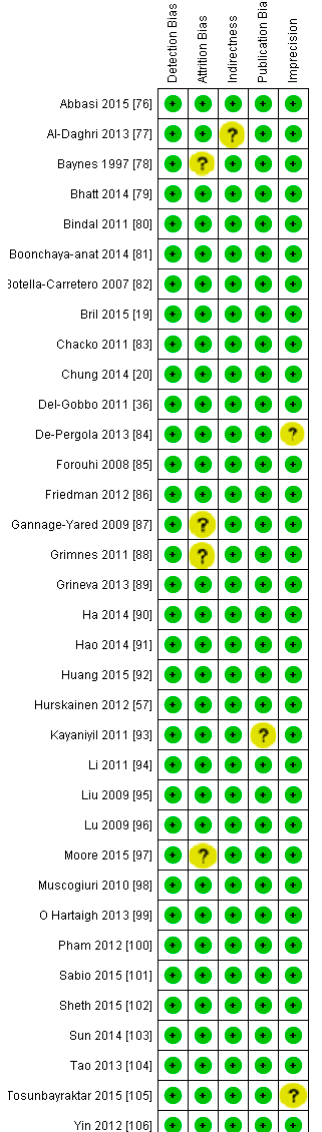
Figure 4. Meta-regression analysis for non-diabetic subject studies. Method of determination of vitamin D R 2 shows the effect of the moderator on the heterogeneity of correlation. ( a ) total variance in true effects; ( b ) not explained by model; ( c ) explained by model.